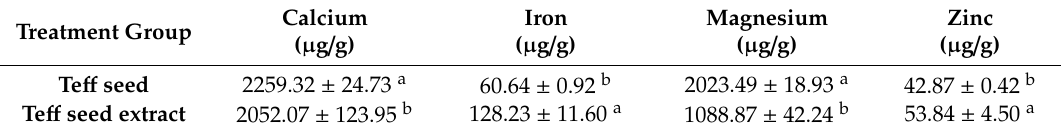
Table 2. Concentrations of calcium, iron, magnesium, and zinc in te ff flour and te ff extract 1 .